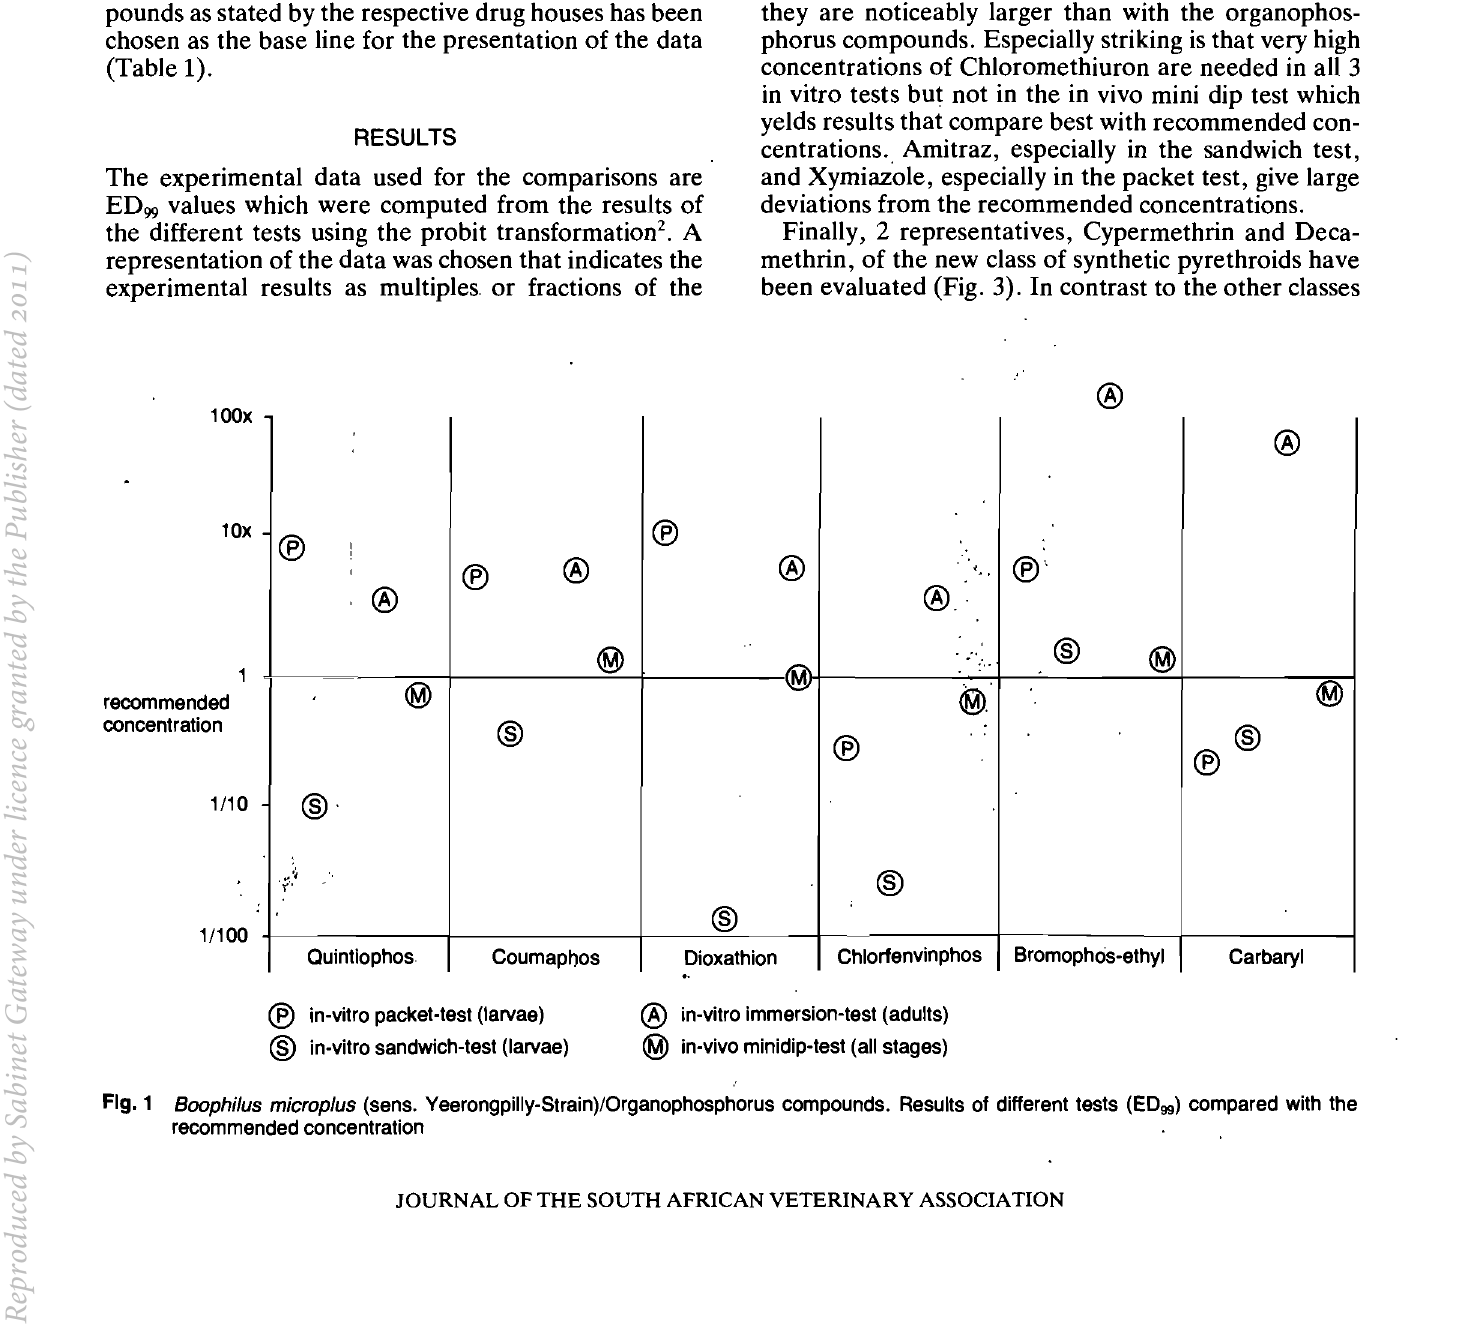
JOURNAL OF THE SOUTH AFRICAN VETERINARY